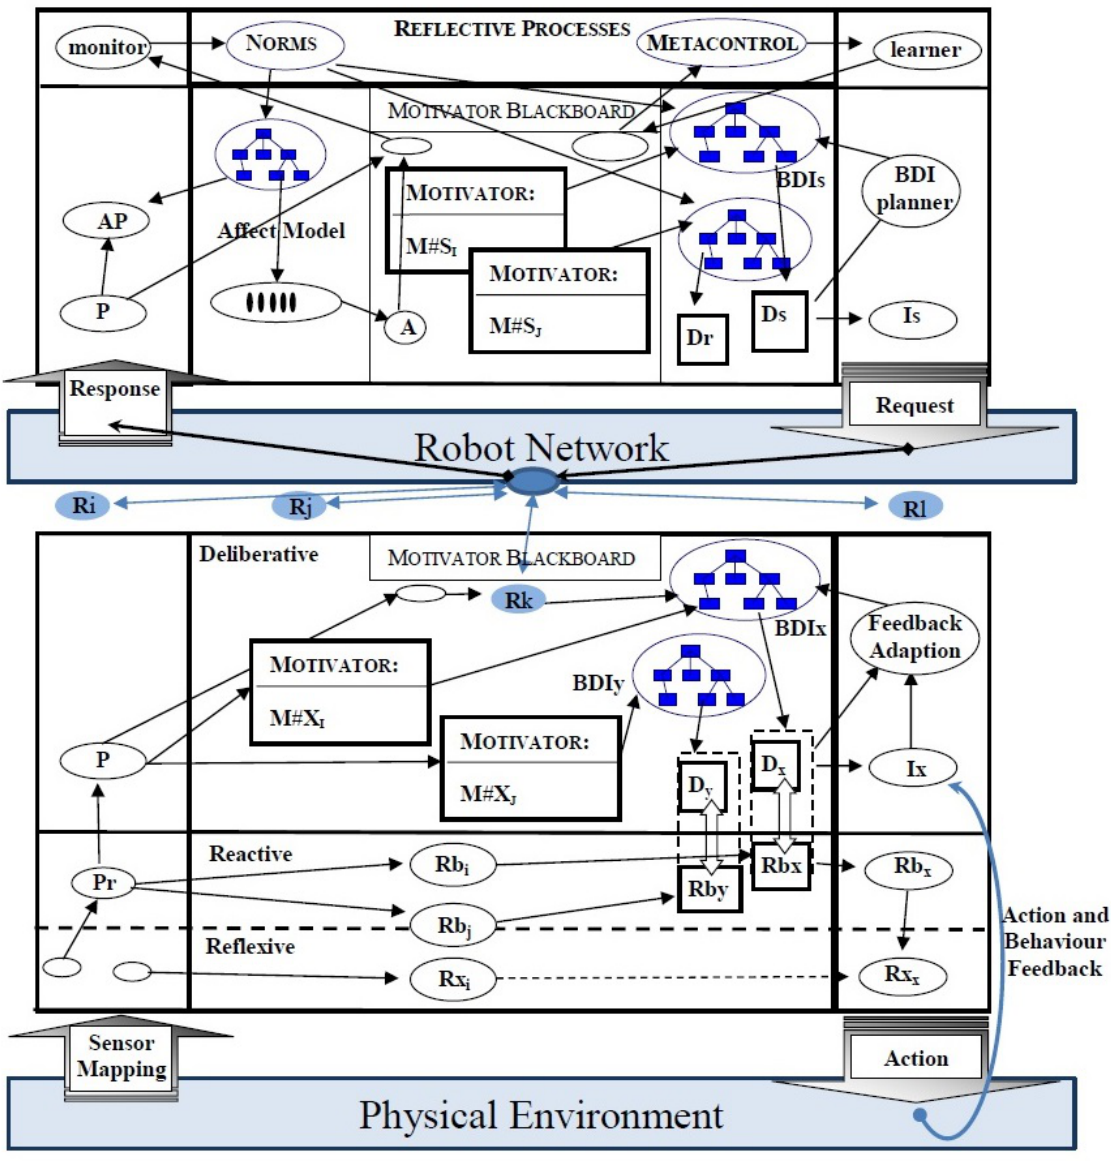
Figure 1: Robot Network and Control Architecture. The upper schematic represents an abstract agency that sits above any number of physical agents (i.e. robots) shown as the blue ellipses associated with the Robot Network (Ri, Rj, Rk, Rl); one of the robot ellipses(Rk) is expanded (as in the lower schematic) and is one of the more sophisticated robot designs (shown to right in Figure 3). The abstract agency may actually reside on a robot with suflcient processing power and/or simultaneously elsewhere across a communication network (as indicated in Figure